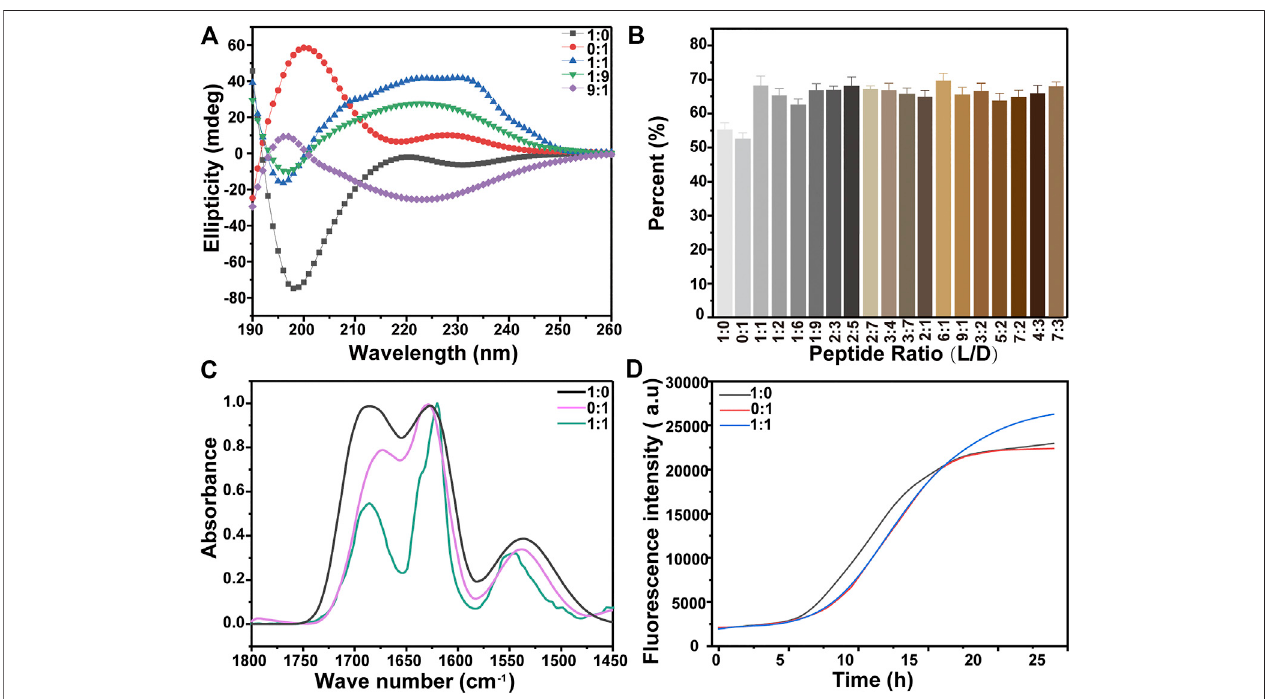
FIGURE 4 | (A) The CD spectra of KK-11, KKd-11, and a mixture of the two peptides (1:1, 1:9, and 9:1 in ratio of KK-11:KKd-11). (B) Percentage of ß -sheet structure in the peptide, which was calculated from the CD spectra using software CDNN. (C-D) FTIR spectra (C) and ThT fl uorescence (D) of the aqueous solutions of KK-11, KKd-11, and their mixture (1:1 in ration),